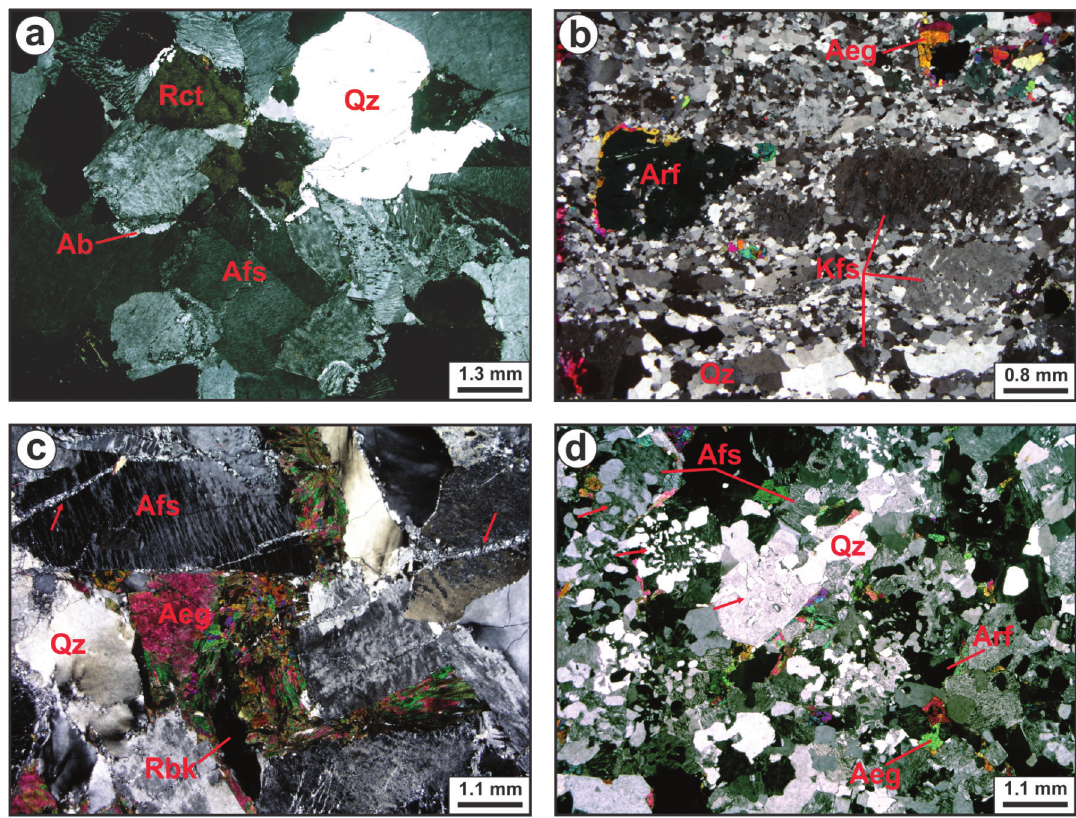
Figure 6 - Microtextural features of the Papanduva Pluton. (a) Textural aspect of alkali feldspar granite of the massive facies showing equi to inequigranular texture with tabular mesoperthitic alkali feldspar crystals (Afs), sometimes with albitic rims (Ab), as well as quartz (Qz) and interstitial ferrorichterite (Rct) crystals. (b) Textural aspect of alkali-feldspar granite of the deformed ‘protomylonitic’ facies, with potassic feldspar (Kfs) and arfvedsonite (Arf) porphyroclasts, the latter mantled by aegirine (Aeg), in a fine-grained recrystallized matrix of quartz (Qz), post-magmatic albite and potassic feldspar (Kfs). (c) Textural aspect of alkali feldspar granite of the deformed ‘cataclastic’ facies, with subhedral, perthitic to mesoperthitic alkali feldspar (Afs), quartz with undulose extinction (Qz) and interstitial aggregates of aegirine (Aeg), as well as some riebeckite (Rbk). Note recrystallized fine- grained quartz filling fractures in feldspar (arrows). (d) Textural aspect of alkali-feldspar microgranite of the microgranitic facies with equi to inequigranular texture defined by tabular alkali feldspar crystals (Afs) with interstitial quartz (Qz), aegirine (Aeg) and arfvedsonite (Arf). Graphic intergrowths between quartz and alkali feldspar are common (arrows). Photomicrographs with crossed